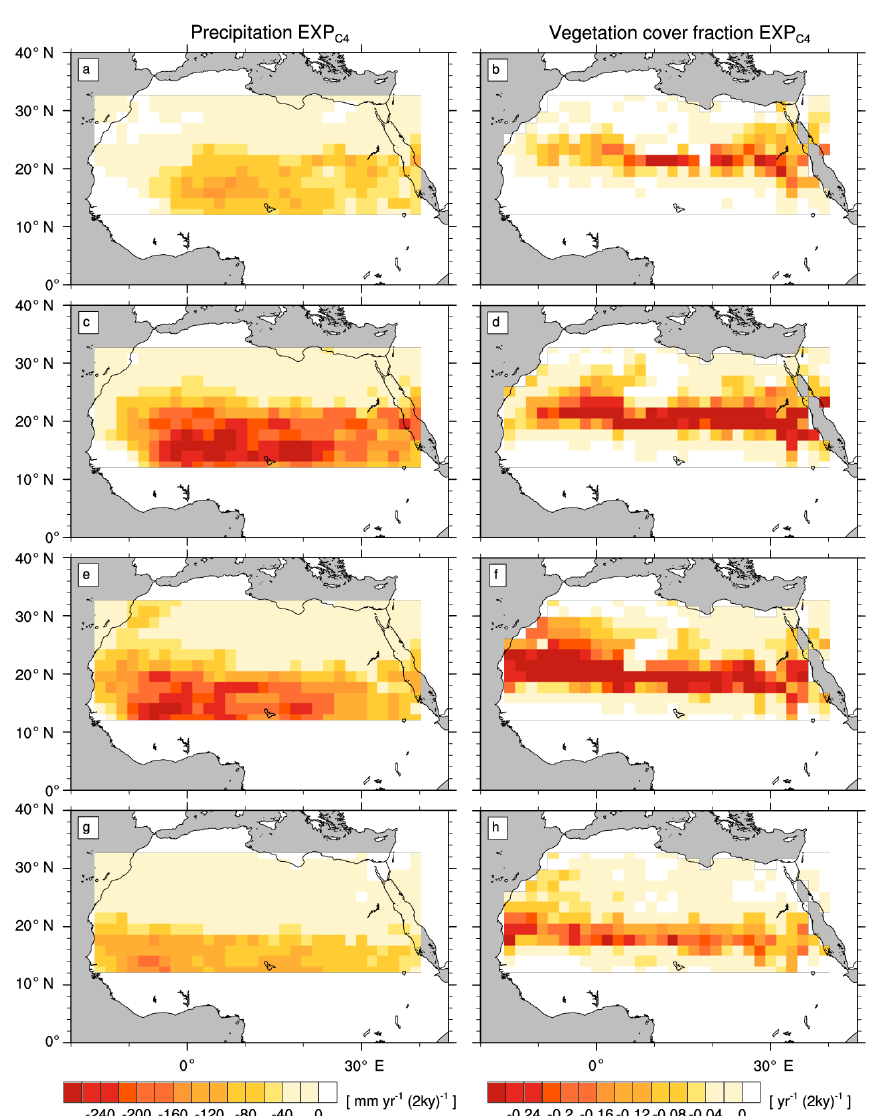
Figure A1. Transition rates from the green Sahara to the desert state for precipitation P (left column) and vegetation cover fraction veg max (right column) of a simulation with C 4 grass only (EXP C ). Plots depict differences between consecutive time slices (100-year averages): 4 6–8kyr (a, b) , 4–6kyr (c, d) , 2–4kyr (e, f) , and 0–2kyr (g, h)